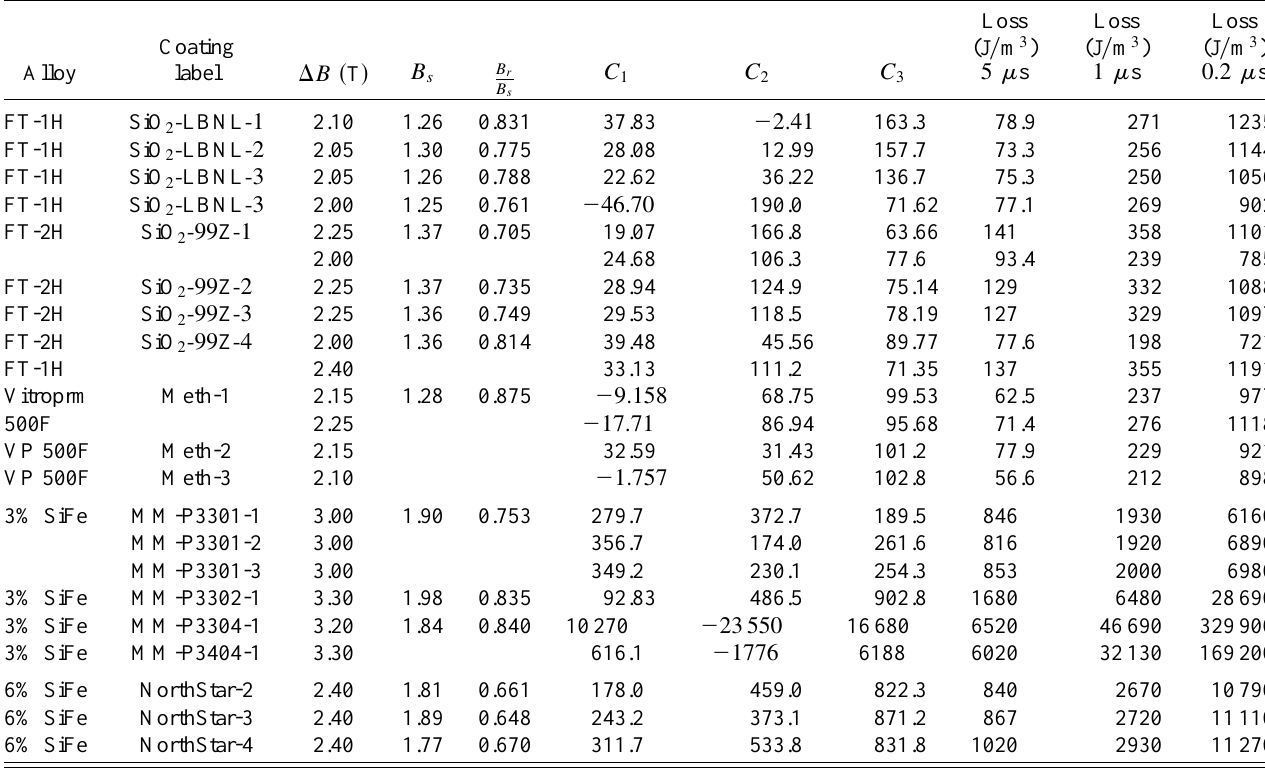
TABLE III. Each nanocrystalline or silicon-steel core reported in this paper is listed with its alloy, its coating and individual label, flux swing, saturation magnetic field, the ratio of the remanent to saturation magnetic field measured for dB (cid:2) dt (cid:5) 2 T (cid:2) m s , the best fit coefficients to Eq. (4)for the listed flux swing, and the losses computed from Eq. (4)for three pulse